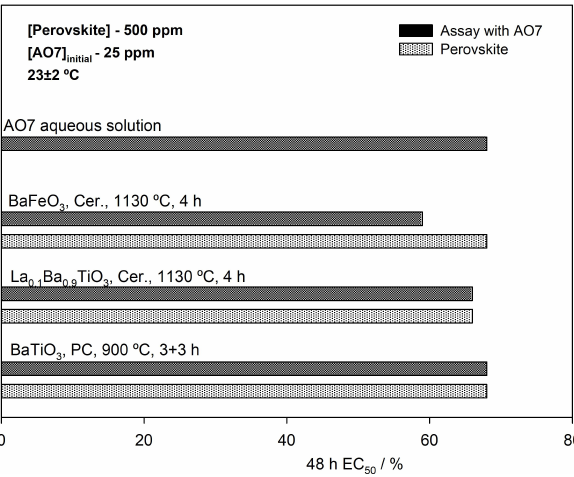
Figure 4: Results of the toxicity assays performed with an AO7 25 ppm aqueous solution and with the supernatant of the centrifuged suspensions of the AO7 photocatalytic assays and with the cen- trifuged suspensions prepared with the different perovskites.